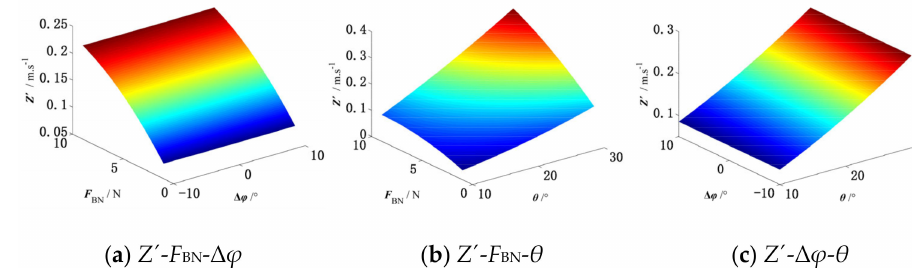
Figure 7. Approximate model of vertical velocity.